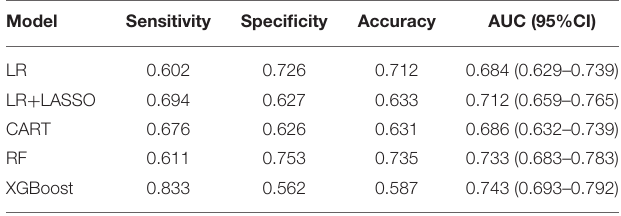
TABLE 3 | Detailed performance metrics for the five models in internal validation.